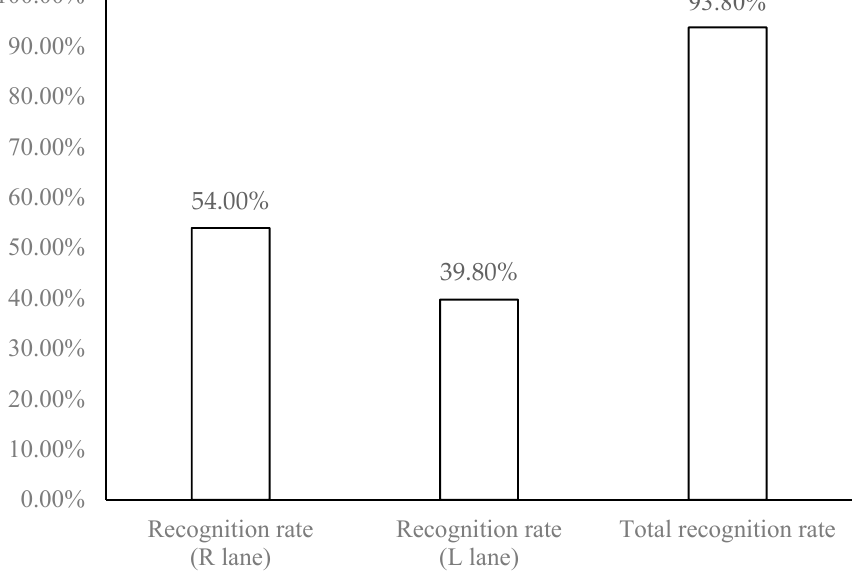
Figure 10. The recognition rate and total recognition rate for vehicle license plate.